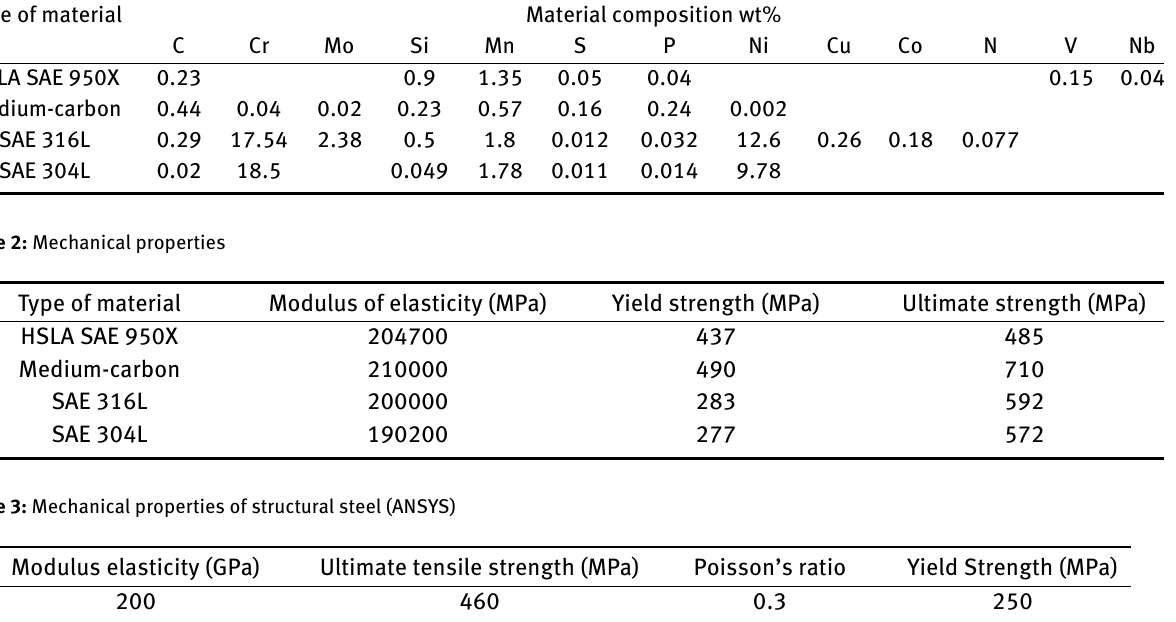
Table 1: Chemical composition Type of material